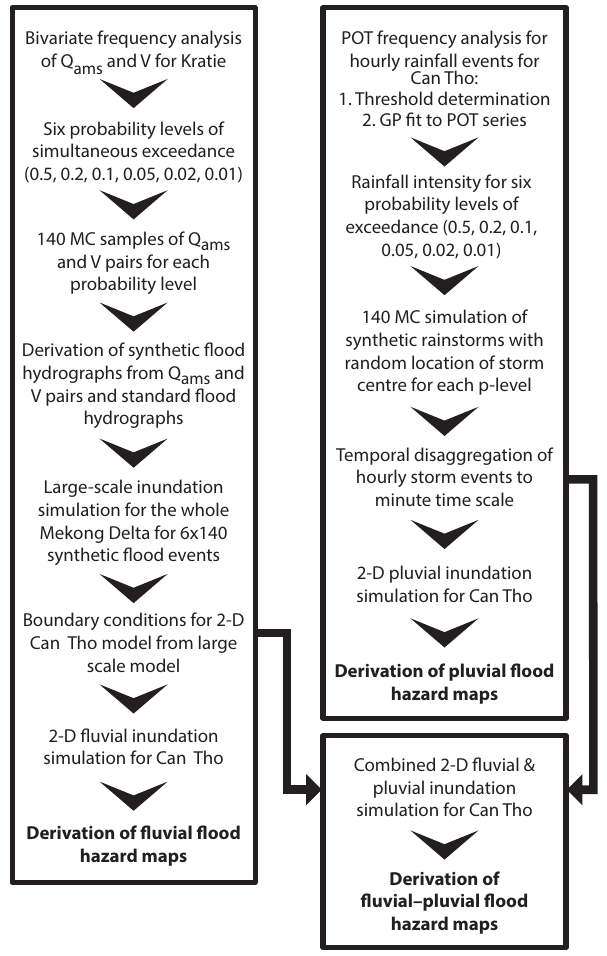
Figure 6. Scheme of the fluvial, pluvial and combined hazard anal-